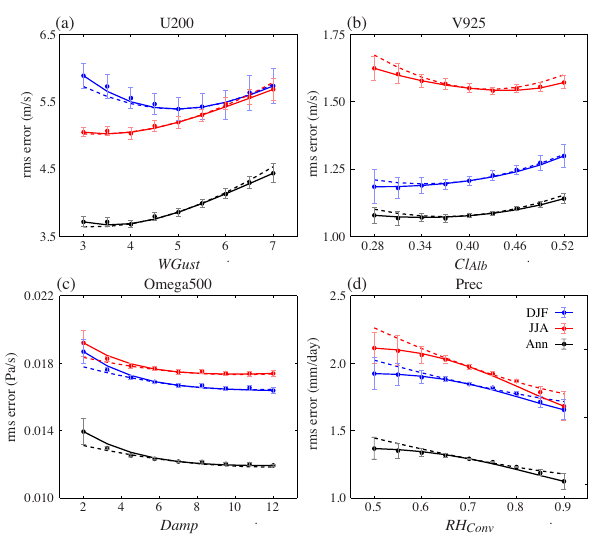
Fig. 1. RMS error of the ensemble mean AGCM climatology of (a) zonal wind at 200hPa for varying WGust, (b) meridional wind at 925hPa for varying Cl Alb , (c) vertical velocity at 500hPa for vary- ing Damp, and (d) precipitation for varying RH Conv in December– February (DJF) in blue, in June–August (JJA) in red, and for an- nual averages in black relative to the National Centers for Envi- ronmental Prediction reanalysis for wind fields and vertical veloc- ity, and to CPC Merged Analysis of Precipitation for precipitation. The AGCM values are compared to the quadratic metamodel re- construction based on the endpoints for each parameter, and to its linear counterpart. Note that the linear metamodel gives quadratic terms (with positive curvature) in the RMS error. Units on abscissa are ms − 1 for WGust, days for Damp and nondimensional for the remaining parameters. Error bars provide an estimate of the spread of the RMS error in the ten ensemble members ( ± 1 standard error of the